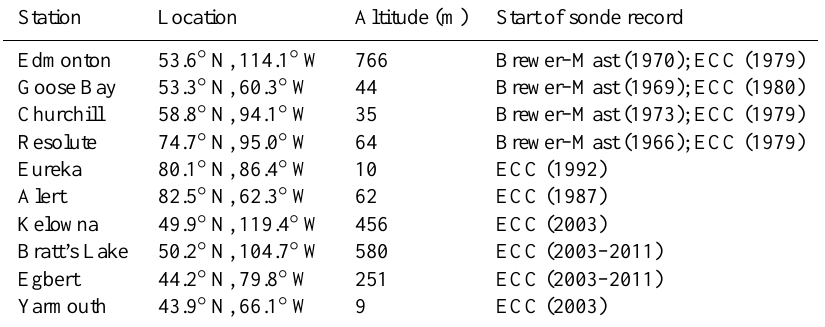
Table 1. The Canadian ozonesonde network. Soundings are weekly (generally Wednesdays), with extra releases during special campaigns (i.e. MATCH, TOPSE, IONS, BORTAS). Regular ozone soundings have been made at Resolute since January